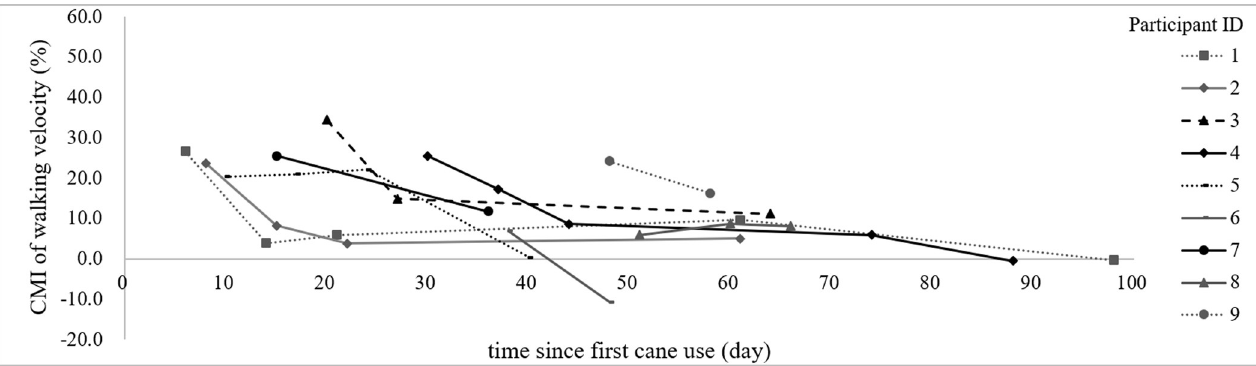
Fig 2. Changes in CMI as a function of number of days since first cane use in each participant. The x axis indicates number of days since first cane use, and each data dot represents one testing session. The y axis is the extent of CMI, with a positive value indicates a deterioration in walking velocity due to dual- tasking. The Wilcoxon signed rank test, performed between the baseline and final sessions, confirmed a significant improvement over time (Z = -2.547; p = 0.011).